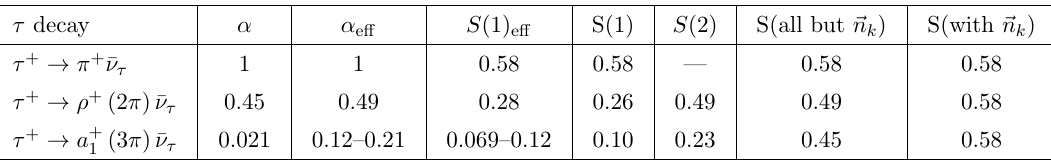
Table 1 . Several (cid:28) hadronic decay channels with asymmetry parameter, (cid:11) , and sensitivities. Sensitivities, S , are shown for the measurements made with di(cid:11)erent number of observables, ~n k is the direction of (cid:28) momentum. Columns 2, 3 and 4 are our calculations and columns 5, 6, 7 and 8 are from the analysis of ref.